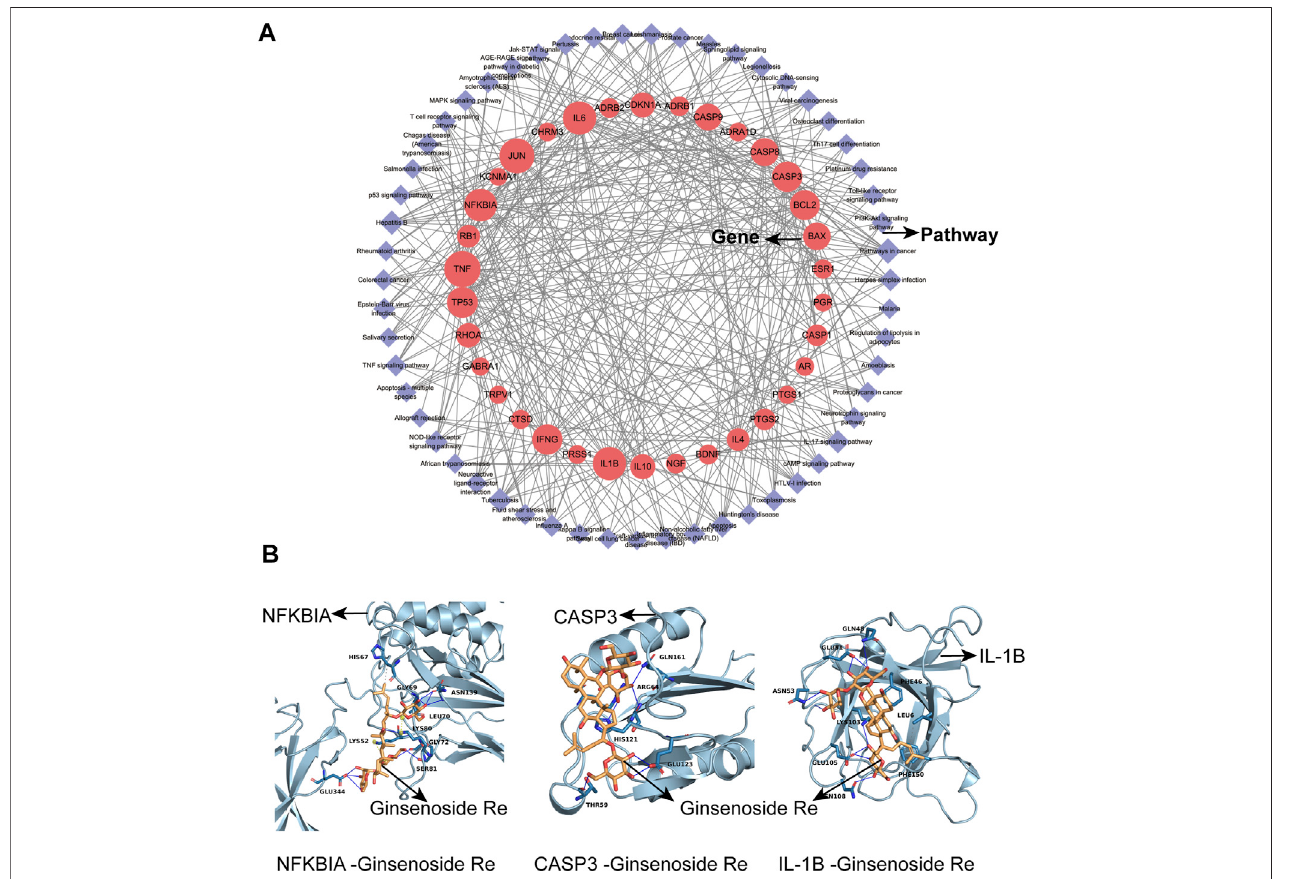
FIGURE 2 | The network of target gene-pathway interactions and molecular docking analysis. (A) The network of target gene-pathway interactions. Red circle stands for target genes and purple diamond stands for pathways. The size of the red circle represents the importance of the target gene in this network. (B) Molecular docking analysis. 3D visualization of NFKBIA-Ginsenoside Re, CASP3-Ginsenoside Re and IL-1B-Ginsenoside Re interactions are presented.